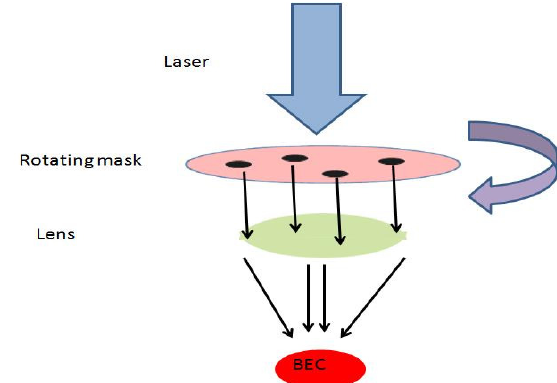
Figure 2. A typical configuration for rotated trap which realizes an abelian gauge potential for neutral ultracold atomic condensate. Here the laser induced optical potential imprinted on Bose-Einstein condensate (BEC) is rotated with the help of a rotating mask. The figure is taken from reference [27]. Reprinted figures with permission from Ghosh, S.; Sachdeva, R. J. Indian Inst. Sci. 2014, 94, 217. Copyright (2014) by the Journal of the Indian Institute of